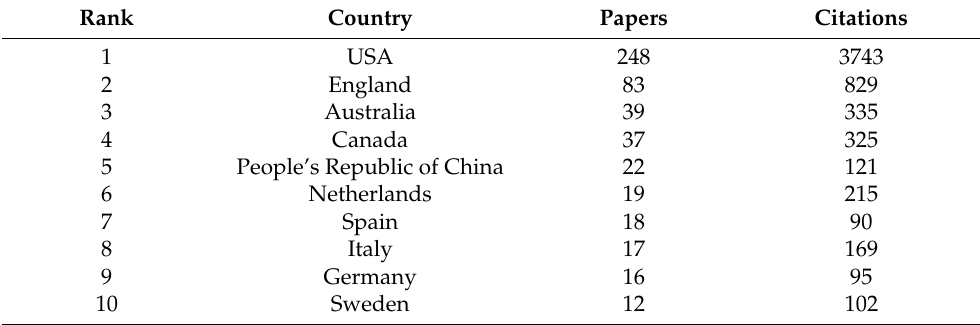
Table 3. Top 10 most influential countries.